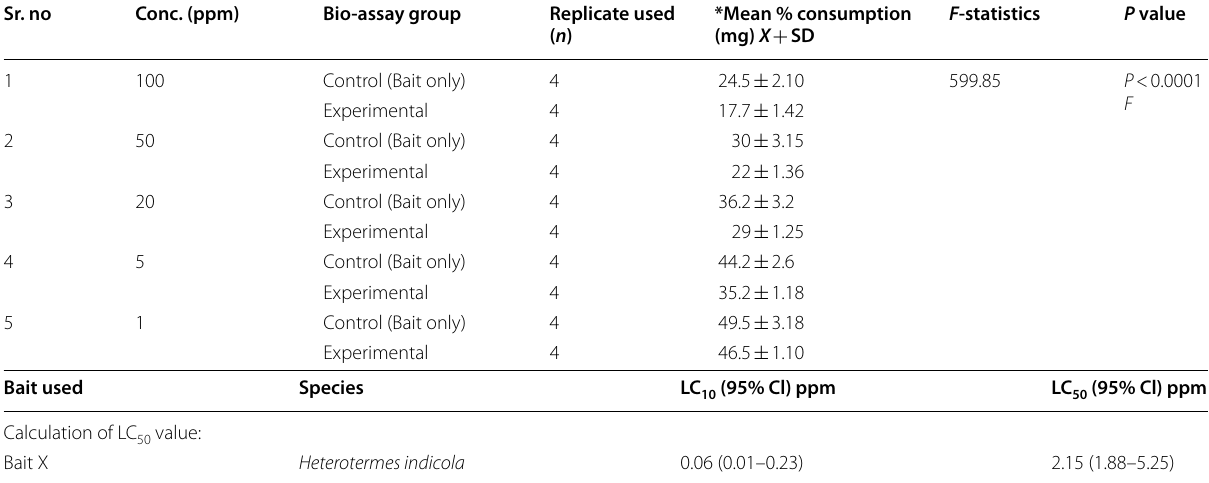
* Mean percentage of consumption for each bait are significantly different ( P < 0.0001) by ANOVA one ways